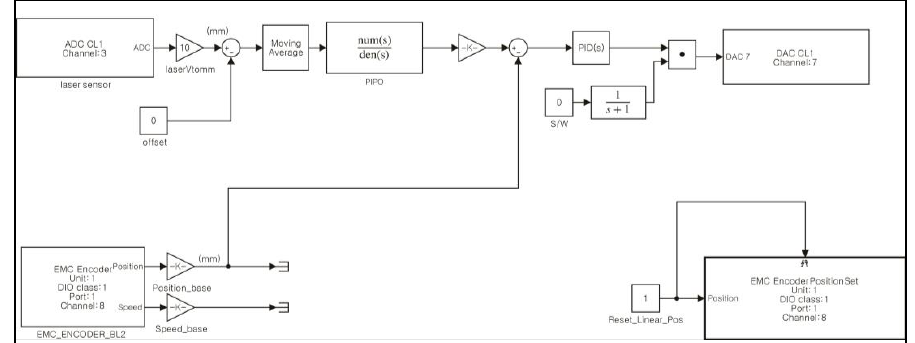
Figure 9. Simulink block diagram for the PIPO controller.